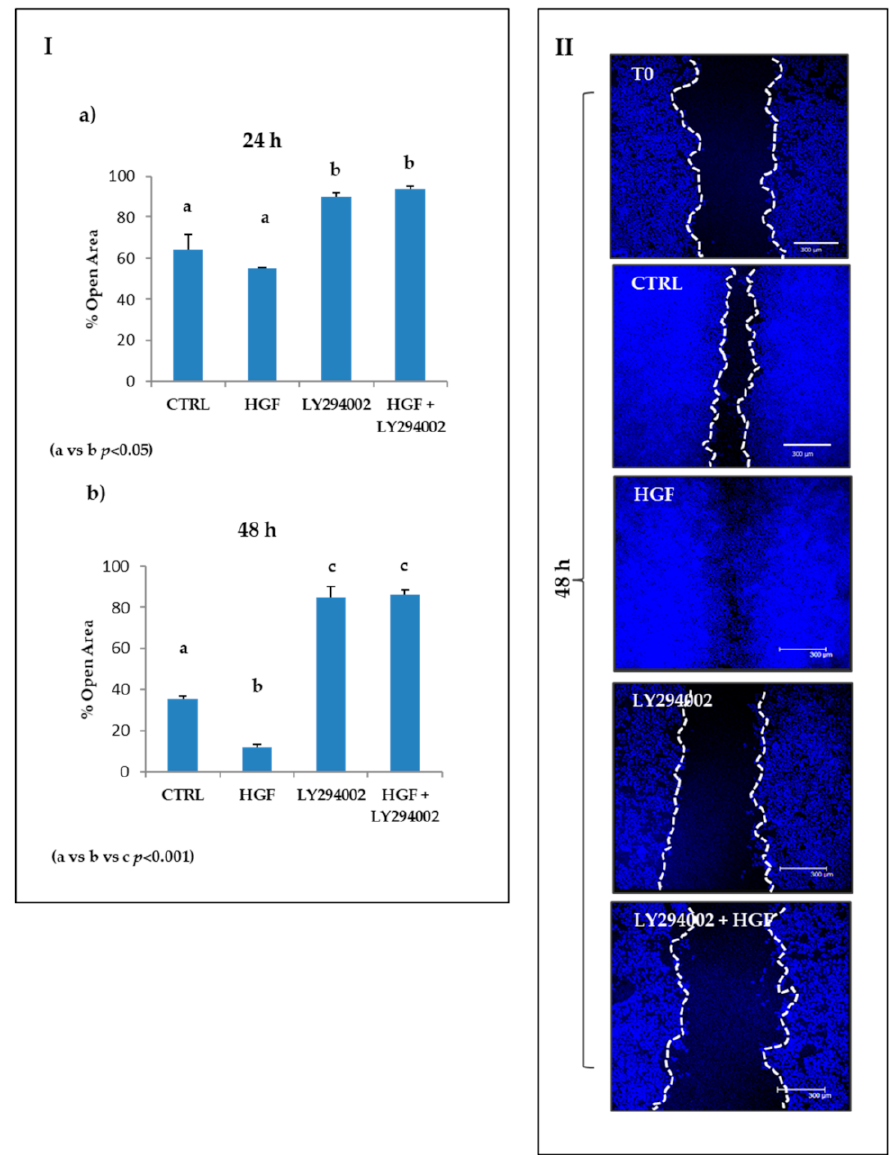
Figure 6. E ff ect of LY294002 on NT2D1 cell collective migration. ( I ) Quantitative analysis of wound closure after 24 h ( a ) and 48 h ( b ). Data are expressed as the mean percentage of residual open area compared with the respective T0 condition. At 24 h, the decrease of open area in HGF-treated cells was not statistically significant compared with the control condition, but the closure was almost complete at 48 h (a vs. b, p < 0.001). LY294002 in combination with HGF at 24 h (b vs. a, p < 0.01) and 48 h (c vs. b, p < 0.001) abrogated the migratory e ff ect induced by HGF. LY294002 alone was also able to inhibit the collective migration of the cells when cultured for 24 h (b vs. a, p < 0.05) and 48 h (c vs. a, p < 0.001). ( II ) Representative images of nuclei in the wound healing assay, recovered immediately after insert removal (T0) and 48 h after wounding. Images were photographed at 10 × magnification (scale bar: 300 µ m). At least three independent experiments were performed in